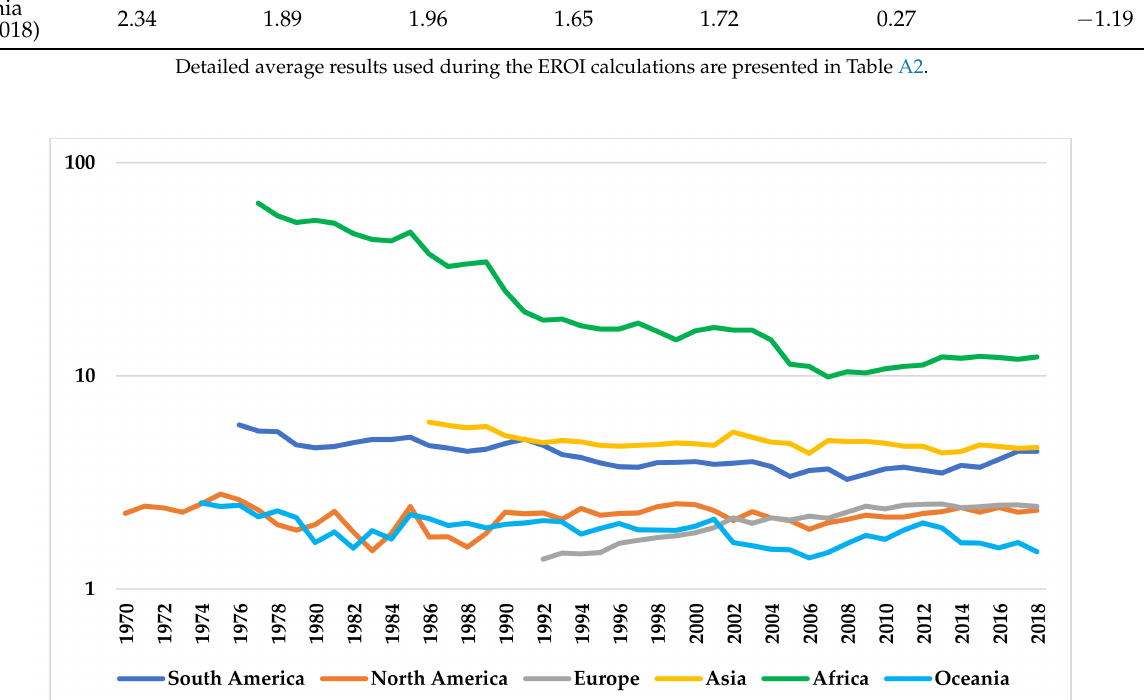
Table 1. Standard deviation, average growth rate and average Edible energy return on investment (EROI) values for years 1970–2018. Standard EROI in EROI in EROI in EROI in EROI in Region Deviation for 1970s 1980s 1990s 2000s 2010s Analyzed Period South 5.35 0.63 − 0.68 America (1976–2018) North America Europe